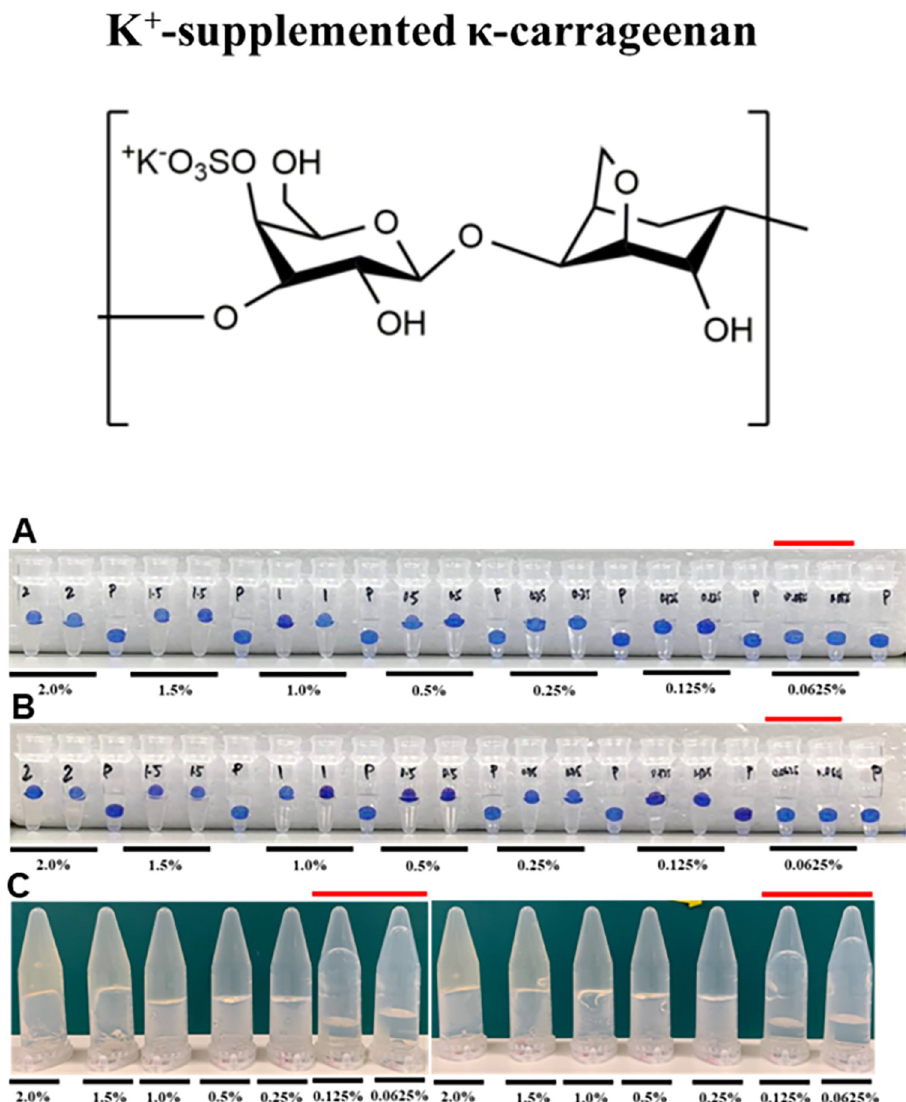
Fig 3. Determining the minimum gelling concentration of potassium-supplemented kappa carrageenan via the floating sphere and inversion assays. Representation of gelation results of potassium-supplemented kappa carrageenan in (a) Thermocycler–Floating Sphere Assay; (b) Water bath–Floating Sphere Assay and (c) water bath– Inversion Assay. Red line indicates the concentrations below the critical gelling concentration. A minimum of three biological replicates was performed. Results from two additional replicates are presented in S3